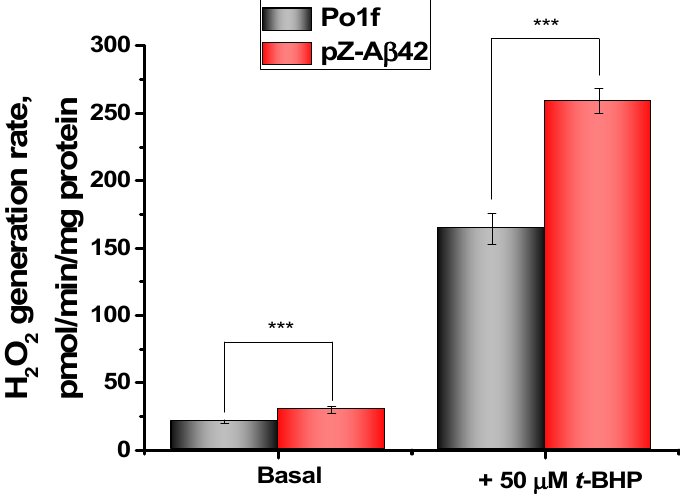
Figure 8. Hydrogen peroxide generation by Y. lipolytica mitochondria. The basic incubation medium was supplemented with 20 mM Tris-pyruvate + 5 mM Tris-malate, 6 mM aminotriazole, 9 U/mL horseradish peroxidase, 5 µM Amplex Red, and mitochondria (0.2 mg protein/mL). Statistical analyses were carried out by one-way ANOVA. *** p < 0.001.